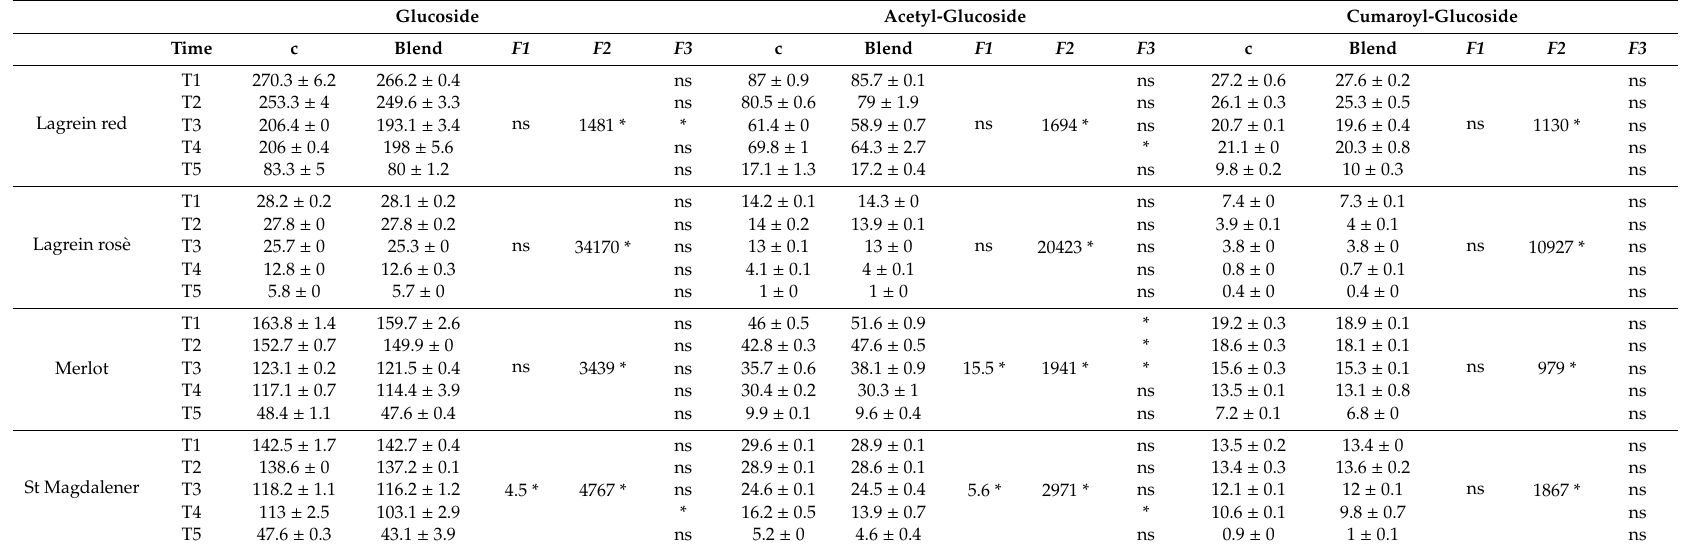
Table 2. Anthocyanin concentrations (mg L − 1 ) and significance of the type of stopper and storage time on their modifications. T1: samples at bottling; T2: after one month of storage at cellar temperature; T3: after three months of storage at cellar temperature; T4: after six months of storage at cellar temperature; T5: after 12 months of storage at cellar